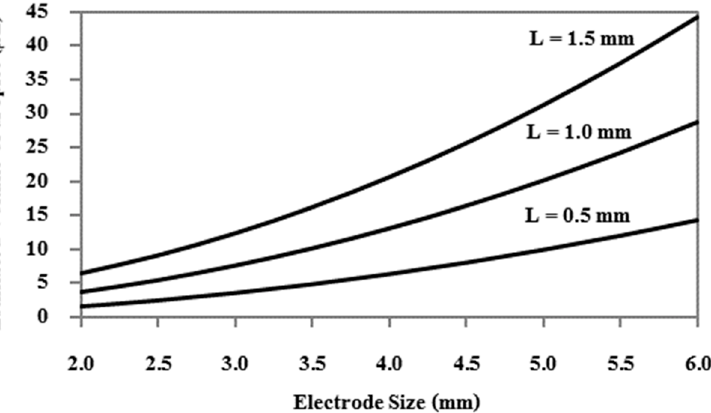
Figure 5. Relation of electrode size ( w ) and the estimated volume of liquid droplets in closed EWOD devices with the distance between the plates ( L ).